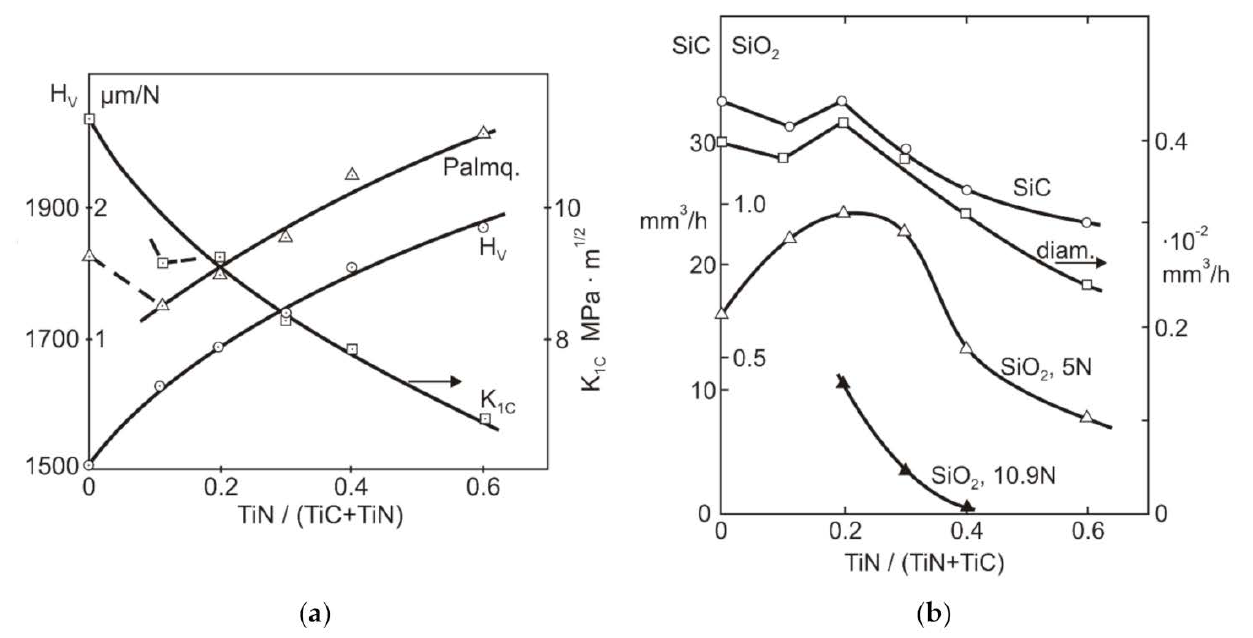
Figure 4. The Vickers hardness and Palmquist cracking susceptibility ( µ m/N), bulk fracture tough- ness K IC ( a ) and abrasion wear rate ( b ) vs. alloy ratio TiN/(TiN + TiC)